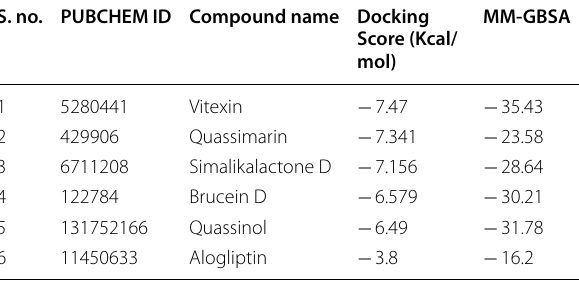
Table 1 Docking and MM-GBSA scores of the top 5 lead compounds